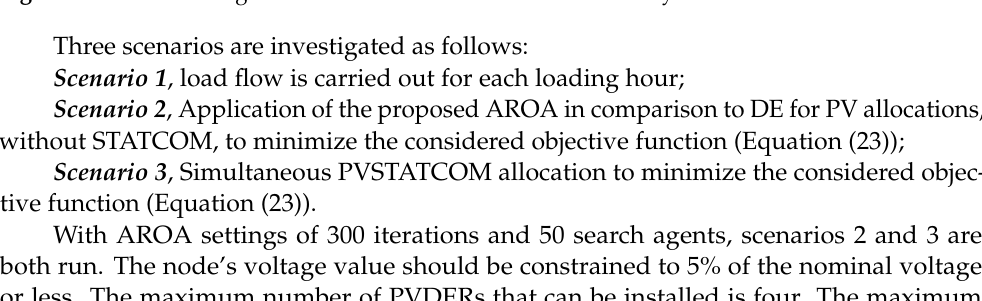
Figure 3. One-line configuration of standard IEEE 33-distribution system.